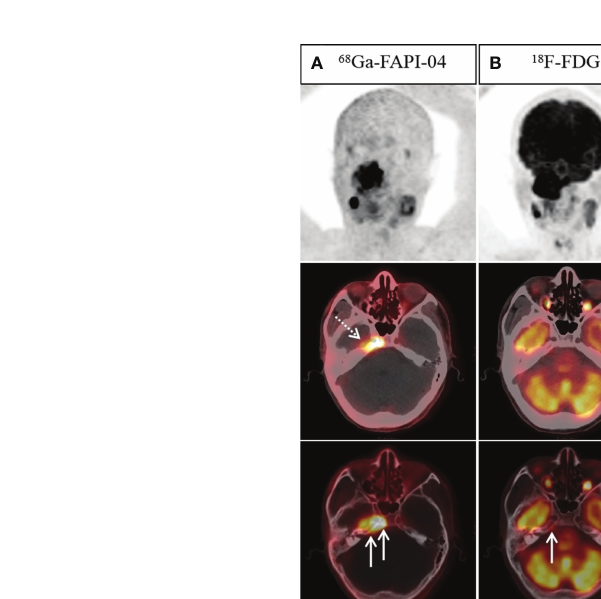
18 F-FDG uptake was seen in the metastatic lymph nodes compared to the non-metastatic reactive lymph nodes (13.6